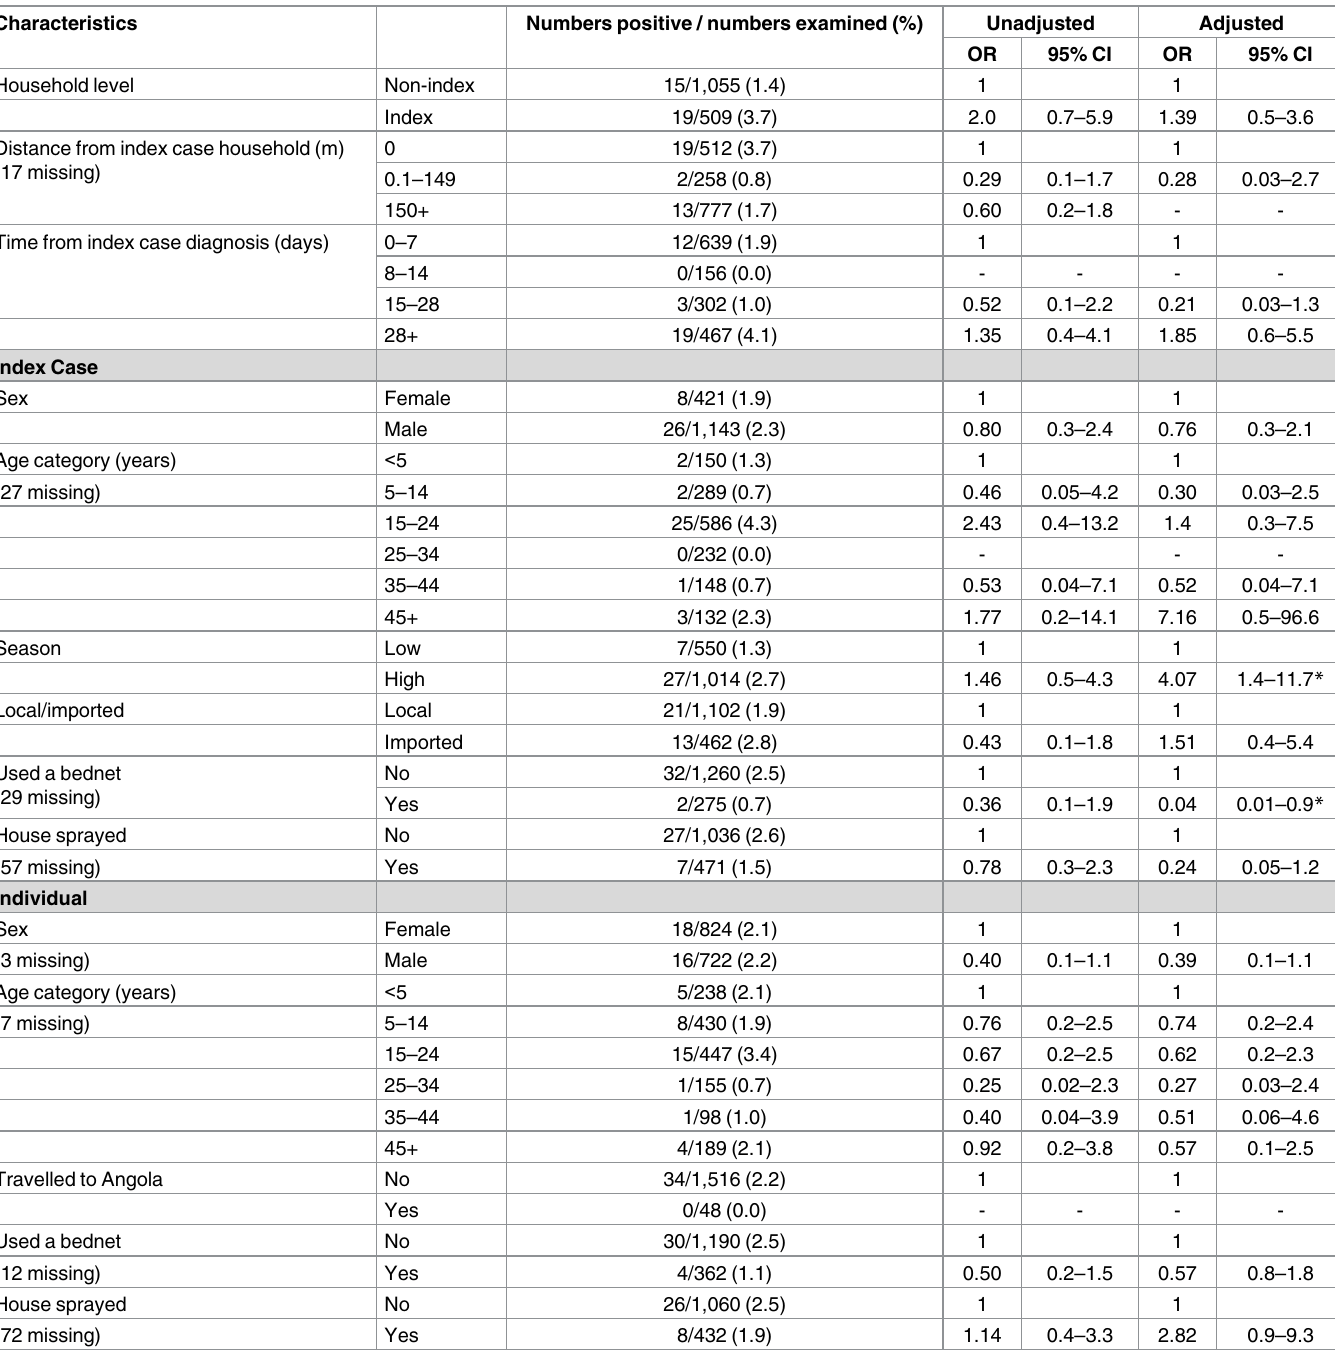
Table 3. Characteristics of 1,564 individuals screenedin caseand neighbours of case households during RACD in Engela.